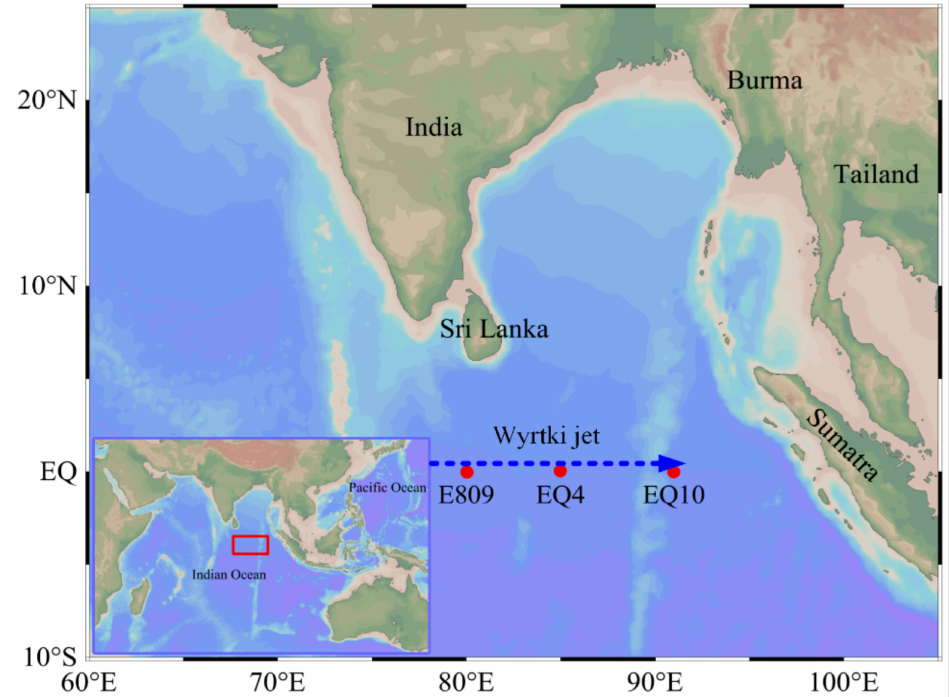
Figure 1. Map of sampling stations (red dots) and Wyrtki jet (blue dotted arrow) along the equato- rial